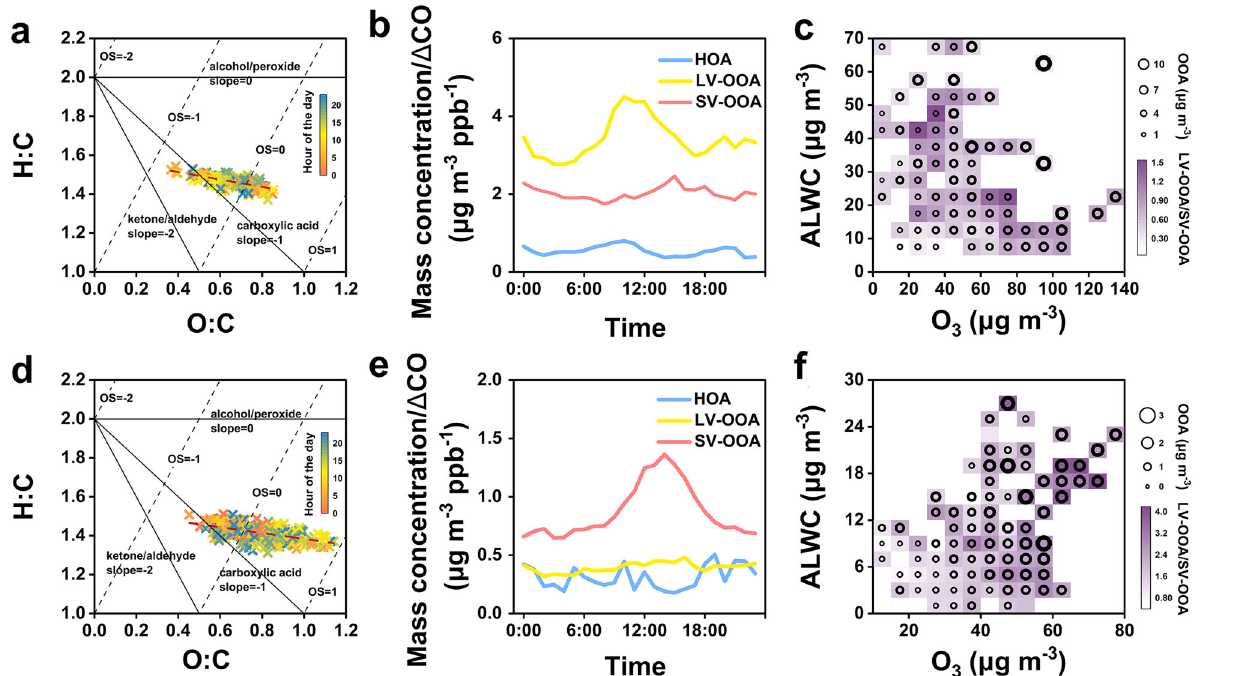
Fig. 3 In fl uence factors of OOA oxidation state. Van Krevelen diagram of the OOA during a the LDP and d MDP; diurnal patterns of the three types of OA (HOA, SV-OOA, and LV-OOA) during b the LDP and e MDP; AWLC and O 3 dependence of the OOA concentration and LV-OOA/SV- OOA ratio during c the LDP and f MDP,